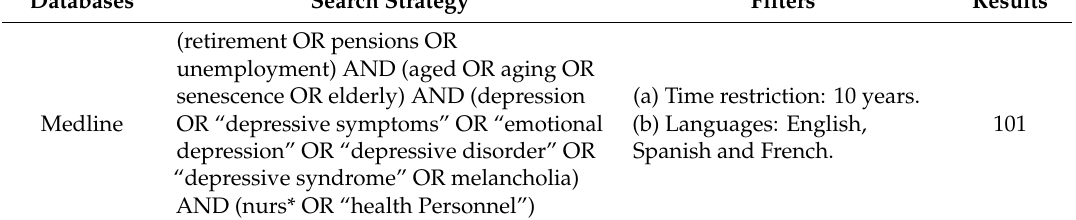
Table 1. Search strategies conducted in the di ff erent